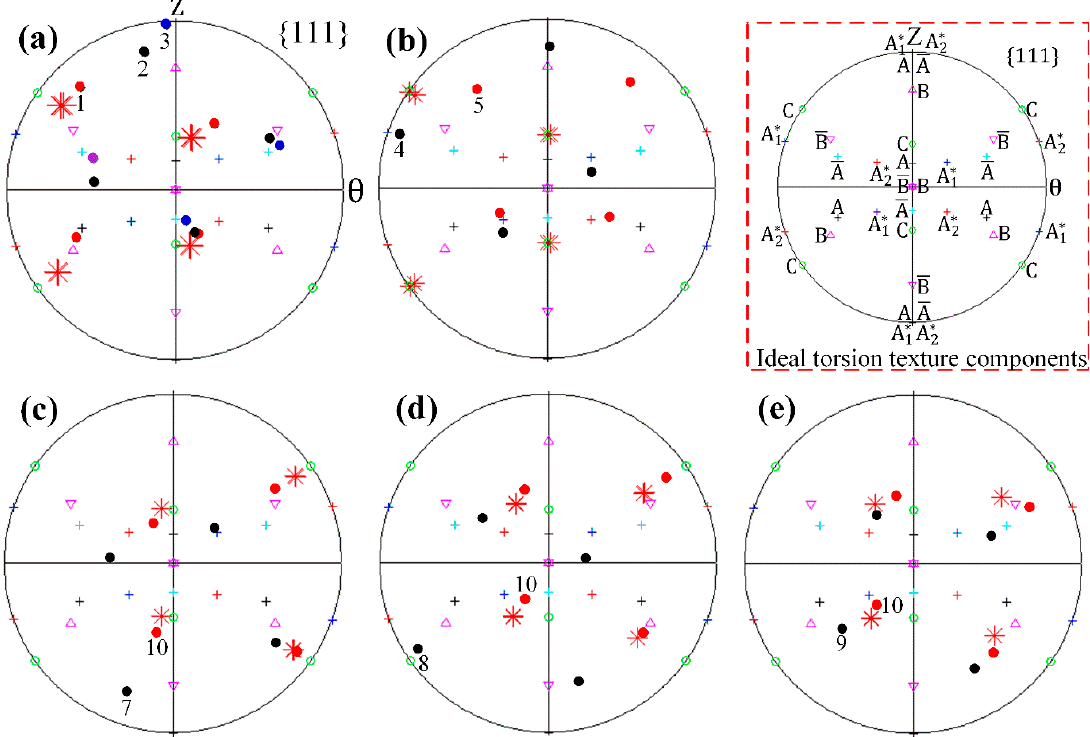
Figure 5. The predicted {111} pole figures of the detected grains along the radial direction. ( a ) Grains 1, 2 and 3, ( b ) Grains 4 and 5, ( c ) Grains 7 and 10, ( d ) Grains 8 and 10, ( e ) Grains 9 and 10.